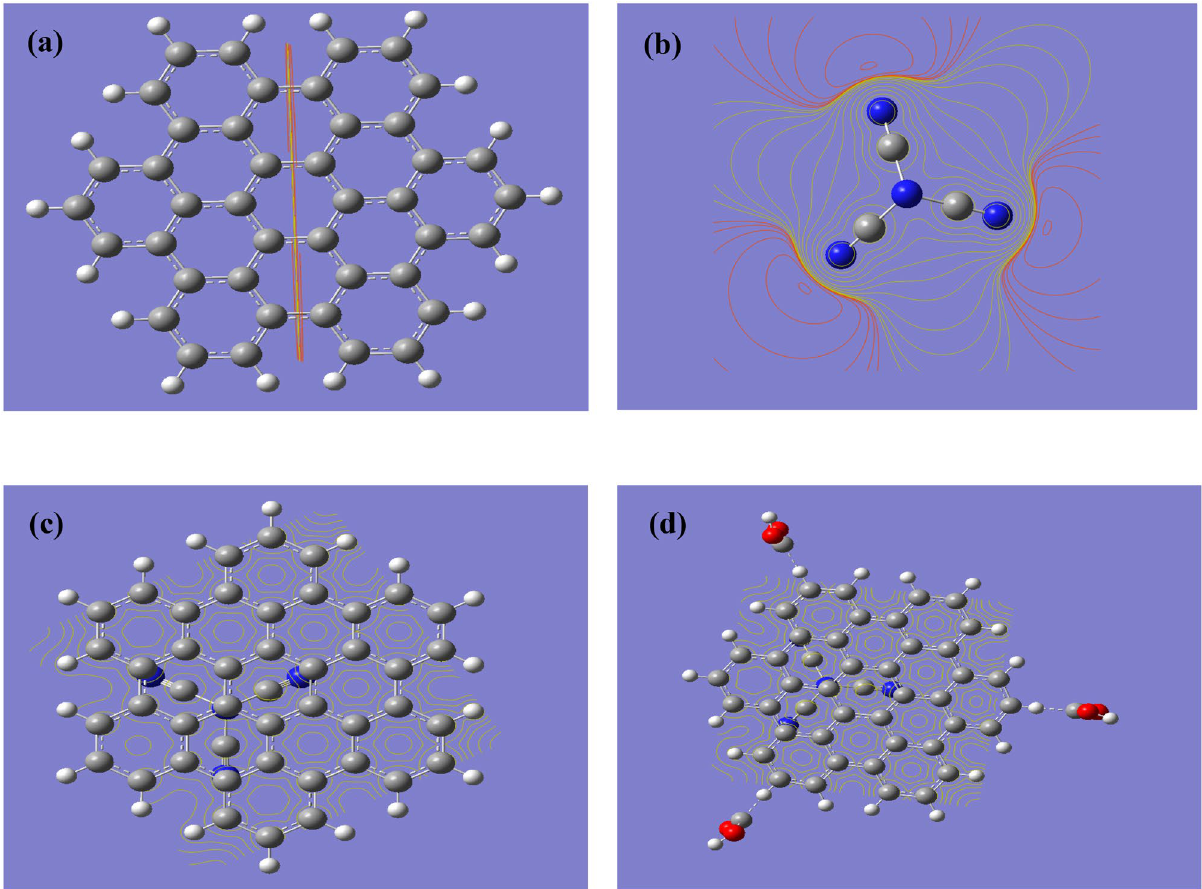
Figure 5. Mapping molecular electrostatic potential at B3LYP/LANL2DZ for the ( a ) Graphene quantum dots GQDs; ( b ) g-C3N4; ( c ) C3N4 /GQDs and ( d ) C3N4/GQDs.3COOH.